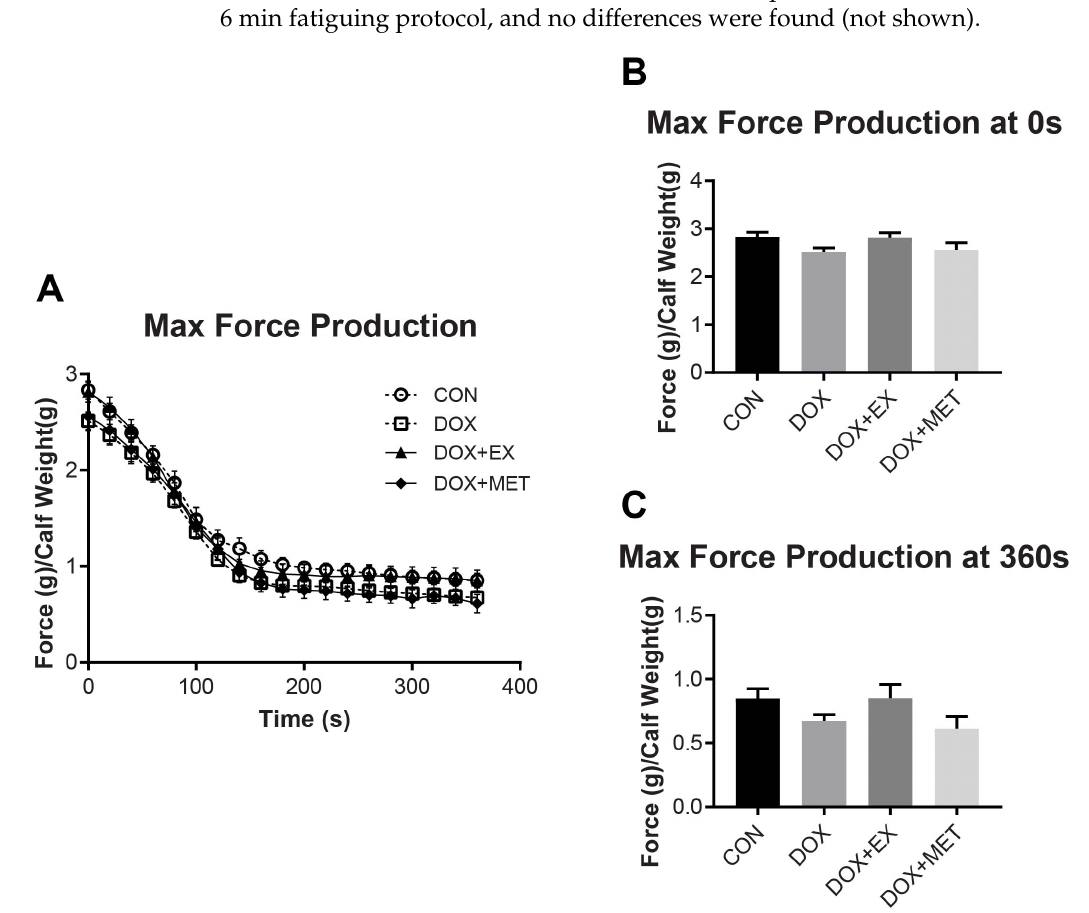
Figure 1. The force Production of GPS complex over 6 min fatiguing protocol. ( A ) the force over 6 min protocol. ( B ) The force at time point 0 s. ( C ) The force at time point 360 s. Data are represented as mean ± SEM ( n = 7–10). No statistical differences were